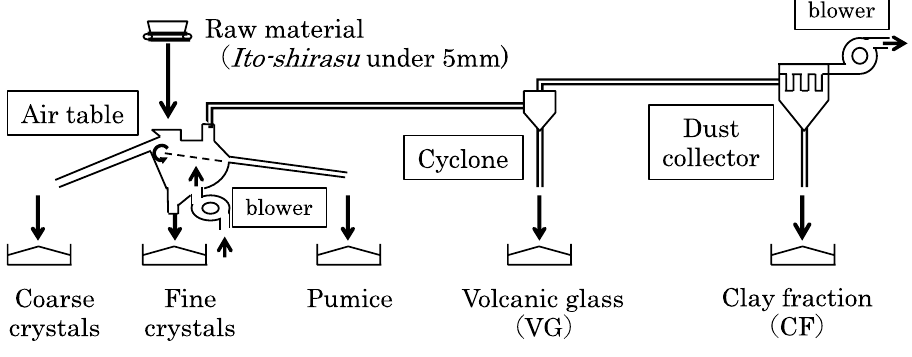
Fig. 5 the dry classifier used. An air table along with cyclone and dust collector classifies Ito- shirasu into five elements